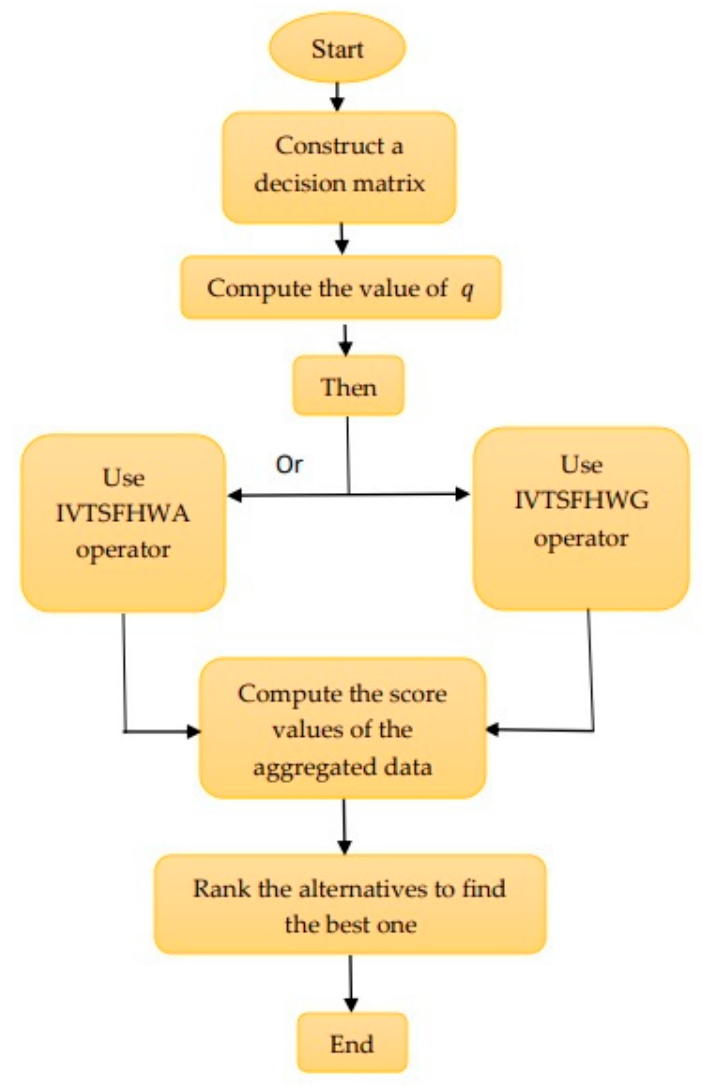
Figure 1 . Flowchart of the MADM algorithm . Figure 1. Flowchart of the MADM